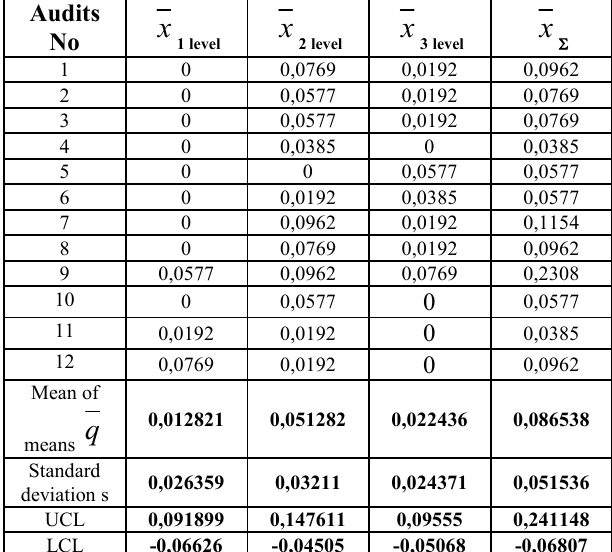
Table 4. The results of statistical evaluation of an internal audit in organization